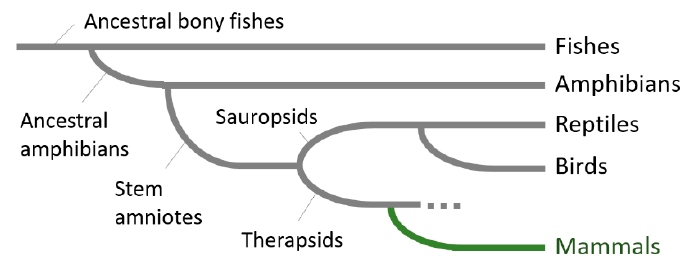
Figure 1. A phylogenetic tree of vertebrate evolution. A diagram showing the lines of evolutionary descent of different vertebrates from a common ancestor. The ancestral bony fish gave rise to ancestral amphibians. Through water-land transition, ancestral amphibians gave rise to stem anamniotes, which then separately evolved into sauropsids and therapsids. Sauropsids are not only the ancestors of existing reptiles but also gave rise to the ancestors of birds. Mammalian species have evolved from therapsid ancestors, although many groups of the therapsids have become extinct (dashed line). The six-layered cortex was inherited by the mammalian ancestor of therapsids (green line) more than 200 million years ago [10]. Modified from Jarvis et al. [11].